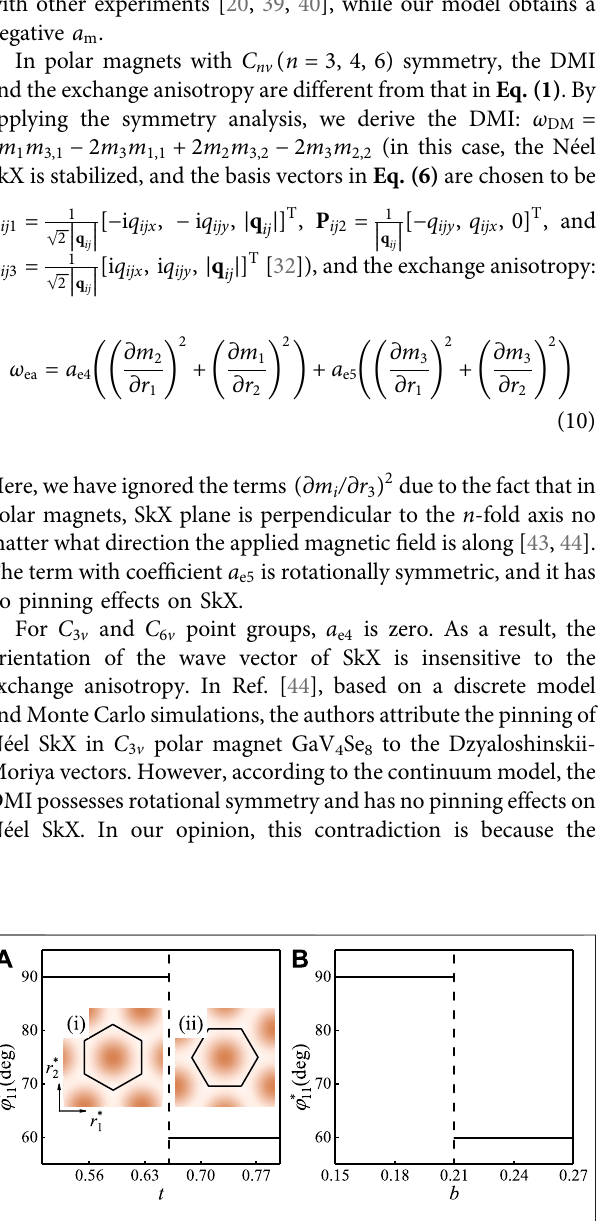
FIGURE 5 | φ * 11 , the angle between the wave vector q d 11 and the r * 1 axis, as a function of (A) t at b (cid:2) 0 . 2, (B) b at t (cid:2) 0 . 65. The anisotropies considered are a e1 (cid:2) 0 . 005 and a m (cid:2) − 0 . 1. The colored density plots i) and ii) show the magnetization along the r * 3 axis at t (cid:2) 0 . 6 and t (cid:2) 0 . 7, respectively. The region encircled by black lines is a skyrmion